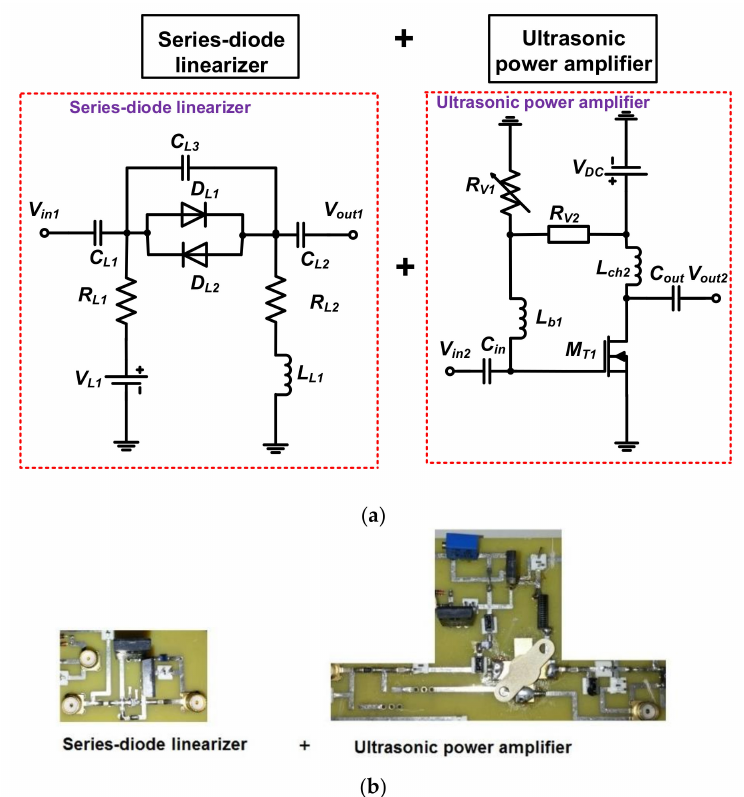
Figure 2. ( a ) Schematic diagrams; ( b ) implemented printed circuit board of the ultrasonic power amplifier and series-diode